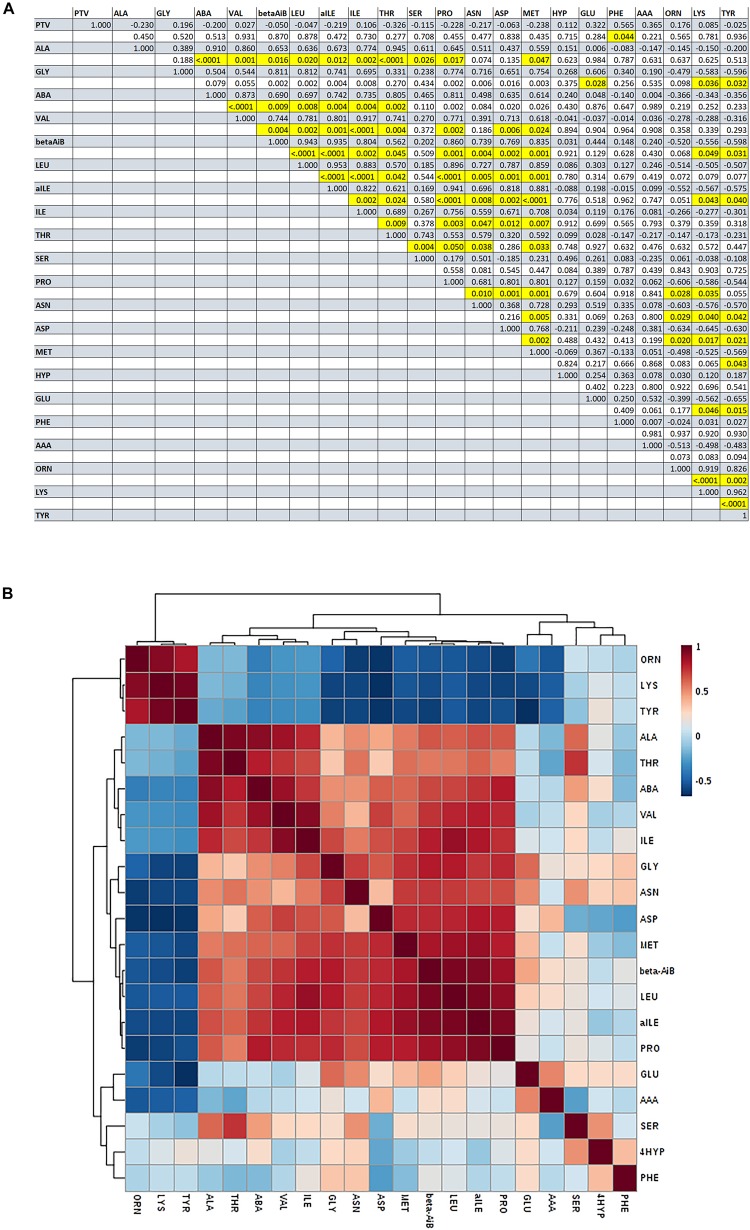
Pearson’s correlations among amino acids identified in bull seminal plasma. (A) Correlation matrix of amino acid concentrations in seminal plasma [shaded lines: Pearson correlation coefficients (r); white boxes: P-value; highlighted boxes: P < 0.05). (B) Heatmap of